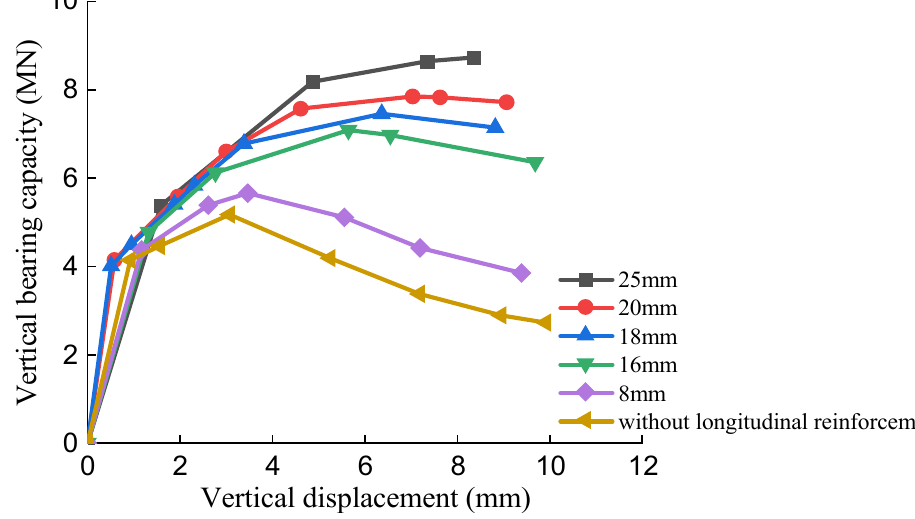
Figure 16. Comparison of different reinforcement ratios.